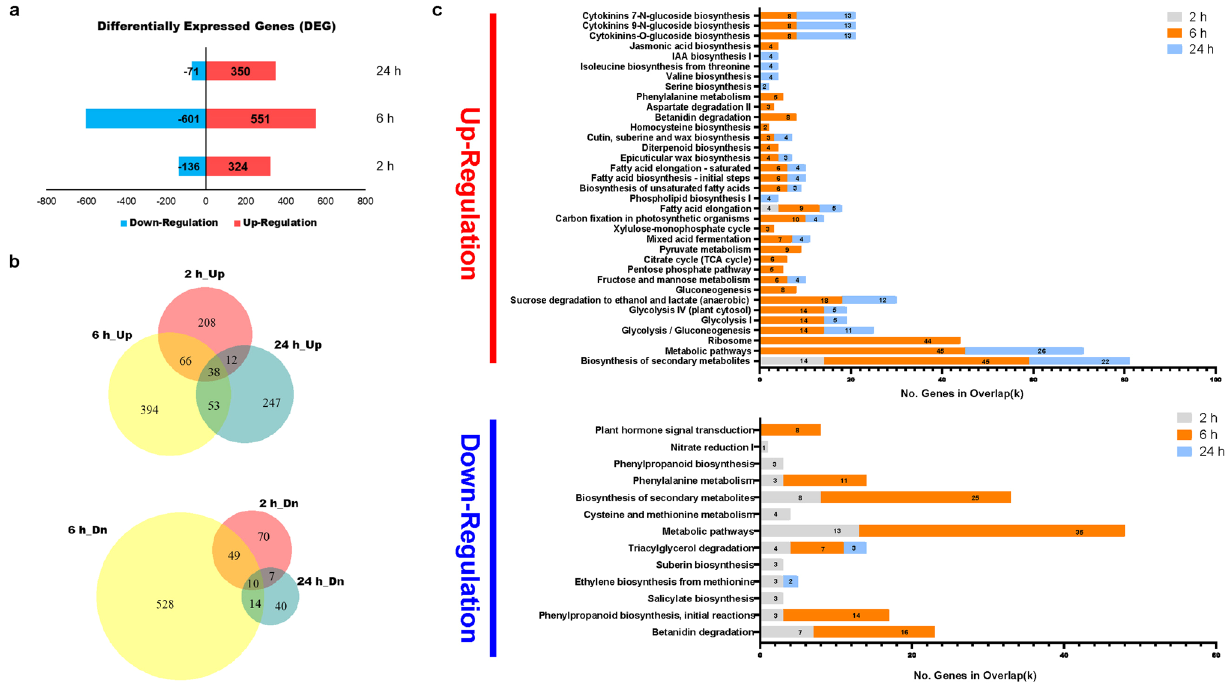
Fig. 2 Analysis of differentially expressed genes (DEGs) in response to zaxinone at different time points. a Numbers of the signi fi cantly expressed genes upon zaxinone treatment (FDR < 0.05). The numbers on the vertical axis represent the three time points while the horizontal axis re fl ects the numbers of up- and down-regulated genes. Up- and down-regulated genes are shown in red and blue bars, respectively. b Venn diagrams showing the numbers of down (Dn) and upregulated (Up) genes that overlap between different time points. c Kyoto Encyclopedia of Genes and Genomes (KEGG) and PlantCyc pathway enrichment analysis for up- and down-regulated genes, which were analyzed by The Plant GeneSet Enrichment Analysis Toolkit (PlantGSEA)